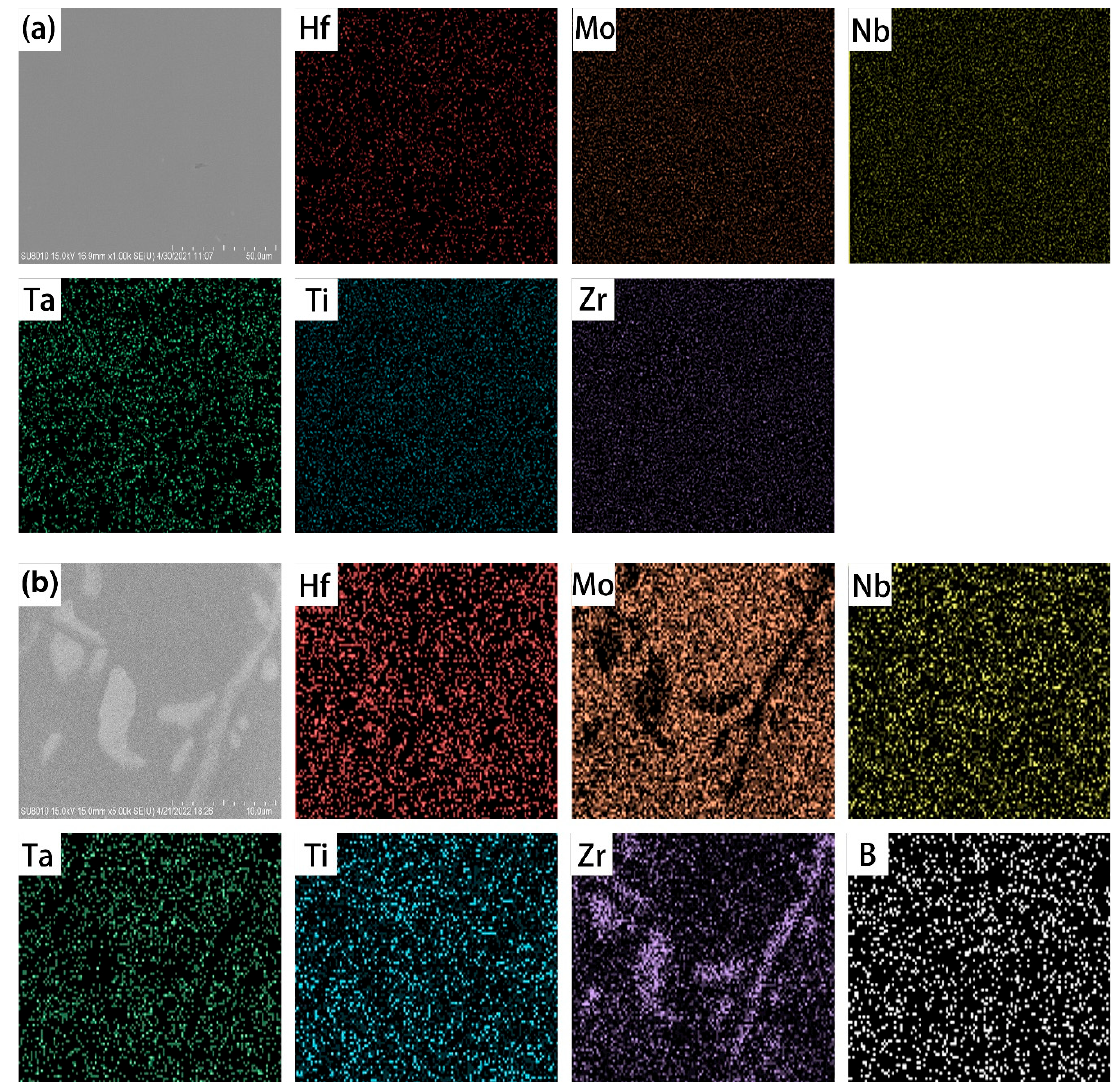
Figure 3. SEM EDS elemental mappings showing ( a ) the uniform distribution of constituent elements in RHEA sample but ( b ) the segregation of Hf and Zr in RHEA-B sample.